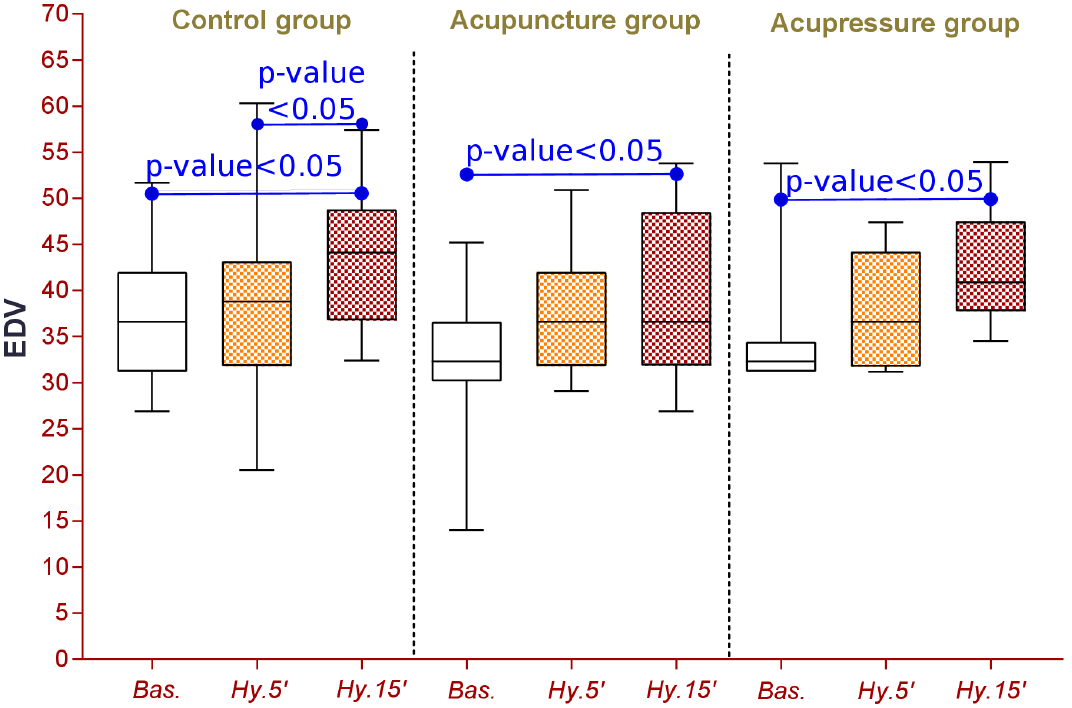
Figure 6. Centimeters per second end diastolic velocity (EDV) in control, acupuncture, and band (acupressure) groups at baseline and after 5 and 15 min of hypoxia.